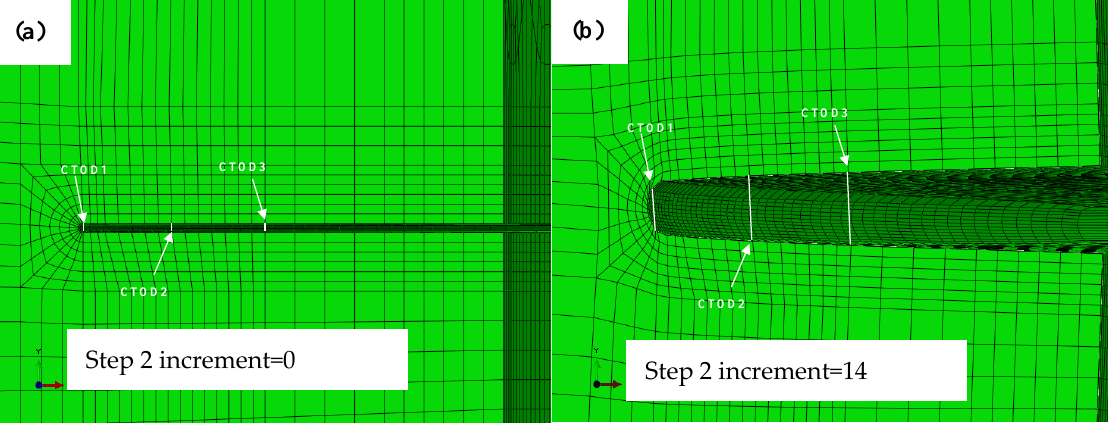
Figure 9. Crack tip mouth changes with load for the FE model (the notch depth is 7 mm). ( a ) The crack tip with tensile strain 0; ( b ) The crack tip with tensile strain 0.019. The CTOD values were obtained by measuring the distance between the two nodes (CTOD1, CTOD2 and CTOD3) near the crack tip. CTOD1 is the distance between the two nodes on the edge of the circular arc transition mesh, CTOD3 is the value a little further than CTOD1, and CTOD2 is the middle value, as shown in Figure 9a.